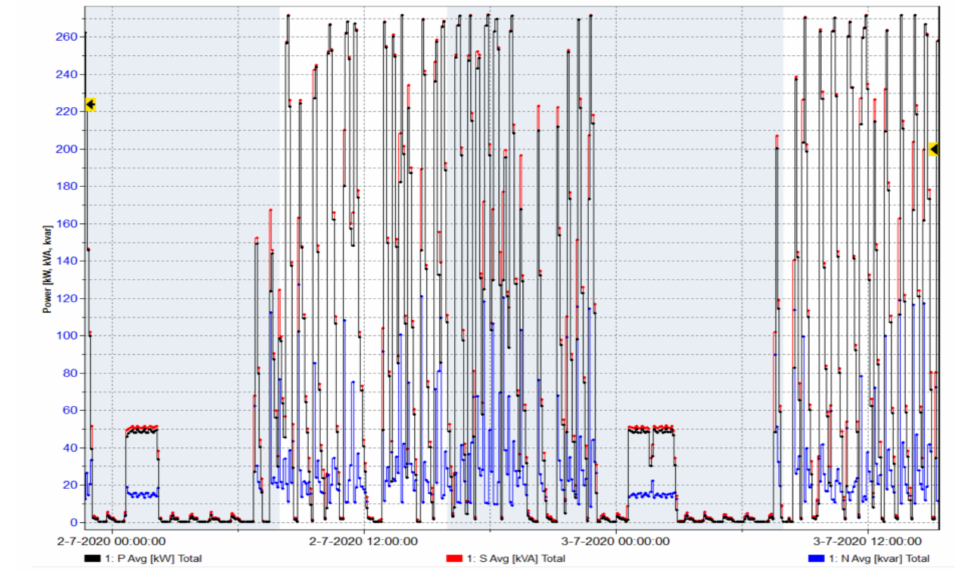
Figure 6. Power demand profile of a fast-charger connected at transformer